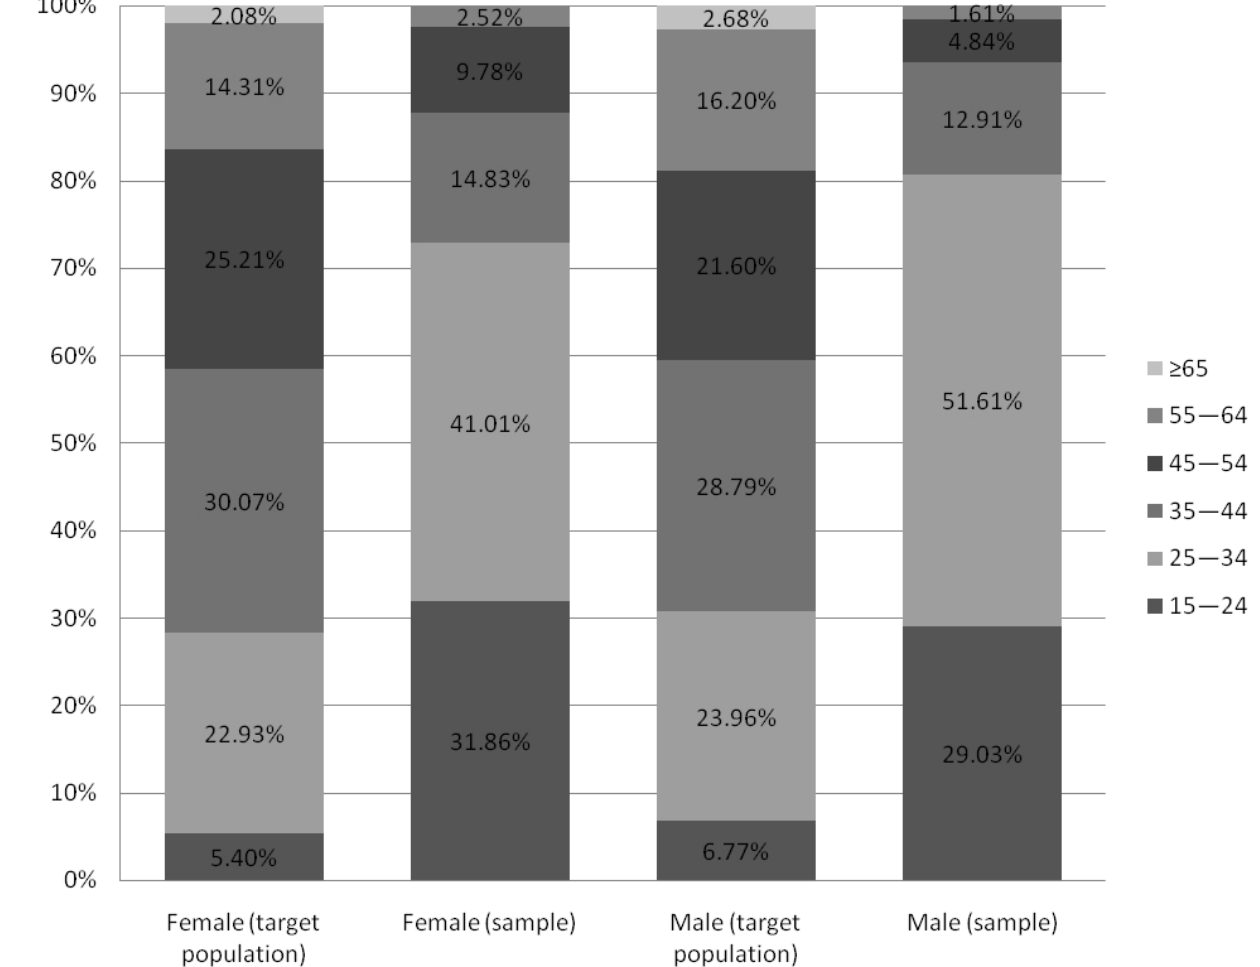
Figure 3. Age distribution of target population and study sample comparison (based on Statistic Poland). Note: Status report on target Polish working population in the 4th quarter of 2020 according to “Yearbook of Labour Statistics 2021”; Statistics Poland